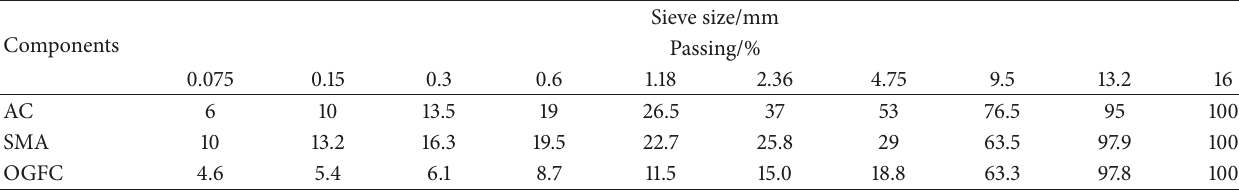
Table 1: Design gradation of asphalt mixtures.